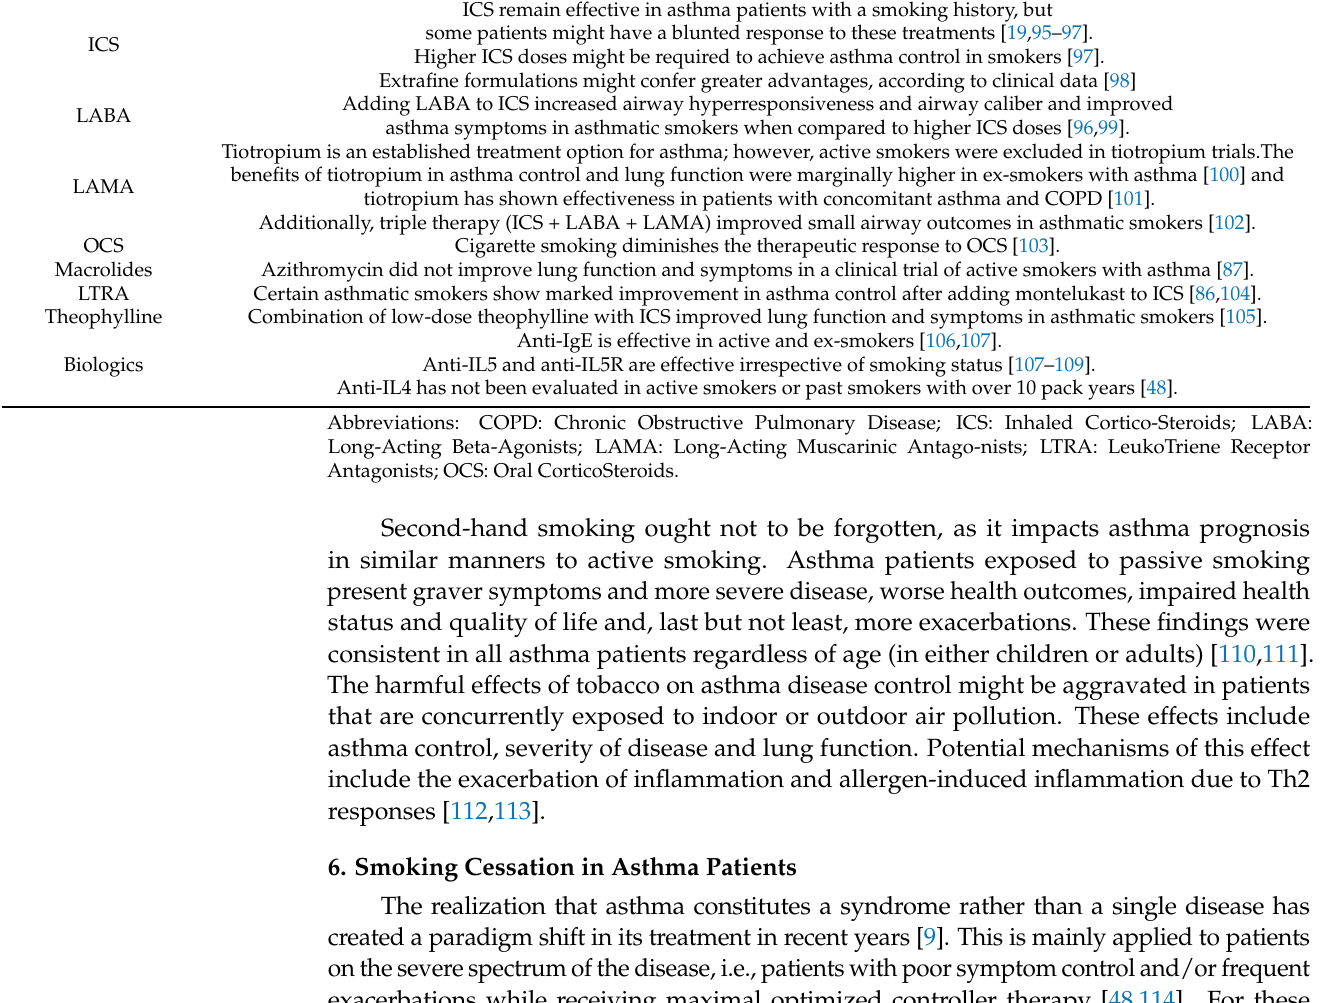
Table 1. Controller treatment options for asthma patients with a smoking history, according to pertinent literature. Findings from Clinical